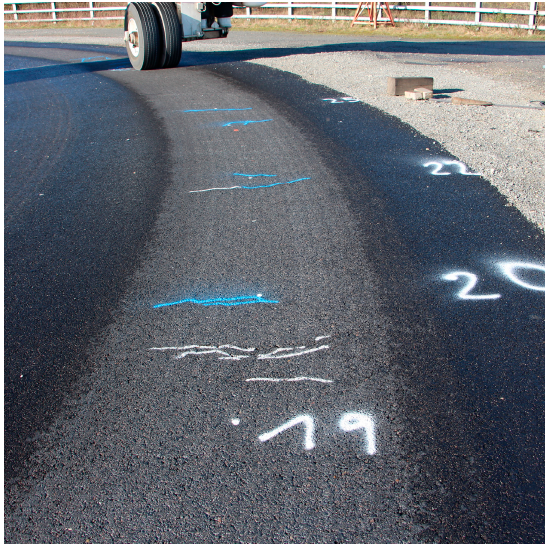
Figure 14. Surface condition of the pavement at the end of the experiment.